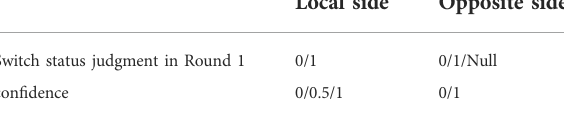
TABLE 3 Connectivity status of STU.